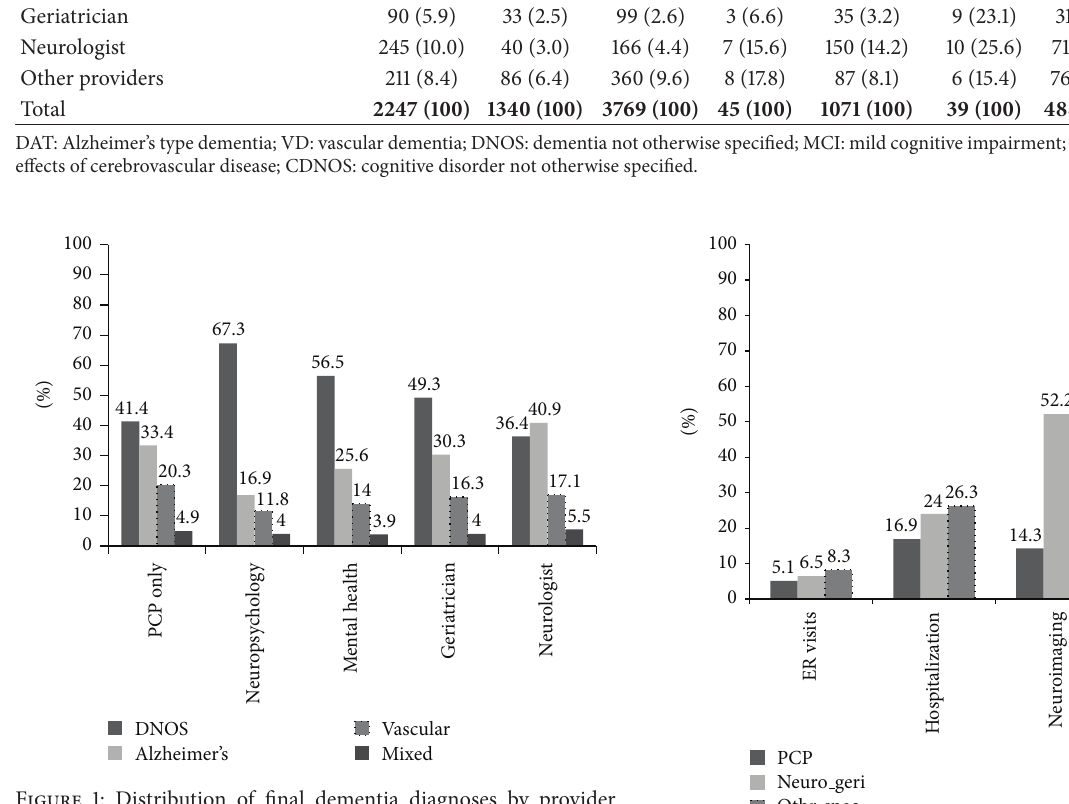
Figure 1: Distribution of final dementia diagnoses by provider category.